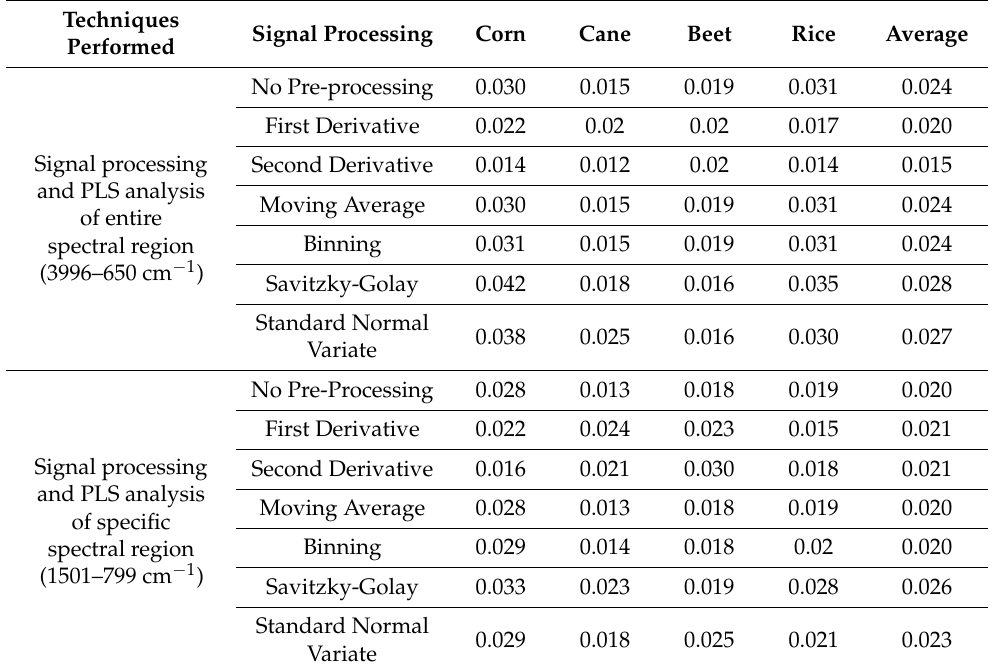
Table 1. Root mean square error of cross validation values for the full factorial training set (n = 81) showing the accuracy of the predicted model (PLS = partial least squares).